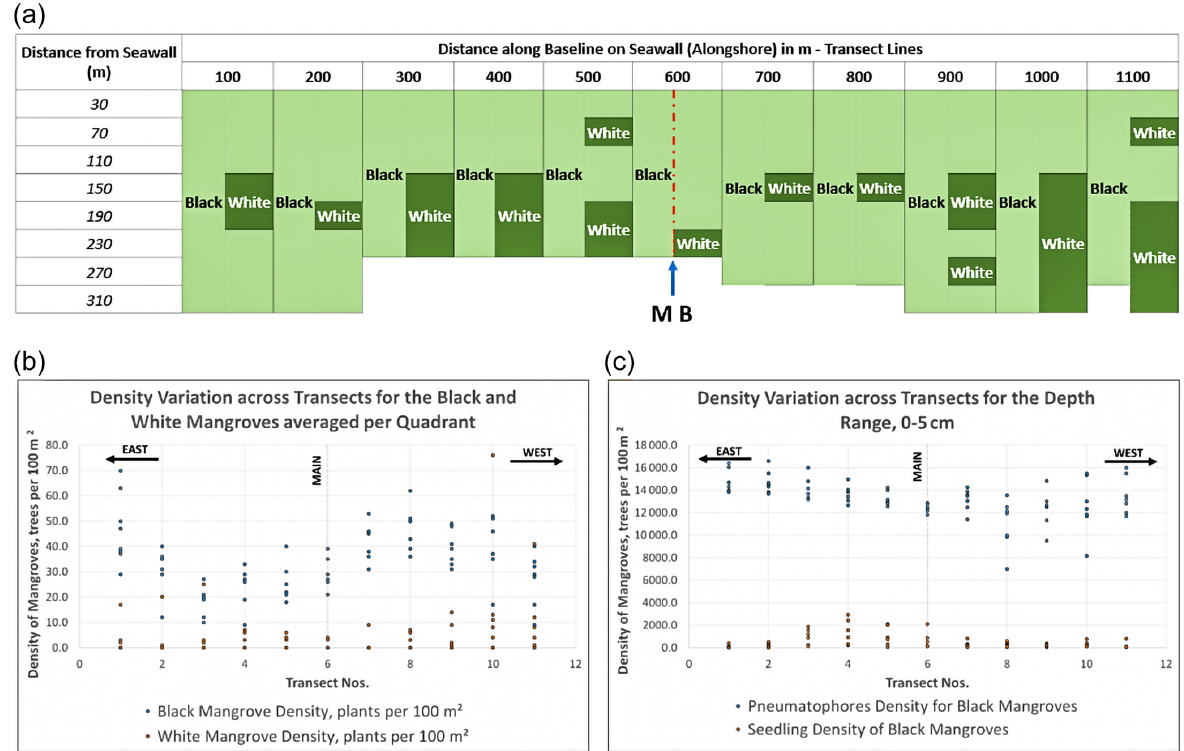
Figure 5. Summary of the spatial variation of the mangrove species and density along the 11 transects at the Chateau Margot mangrove fringe. (a) The demarcation of zones for the two dominant mangrove species, Avicennia germinans (black mangrove) and Laguncularia racemosa (white mangrove). (b) Variation in mangrove density (number of plants per 100m 2 ) for the black and white mangroves. (c) Density variation along depths 0–5cm for the mangrove roots (pneumatophores) and the seedlings for the black mangroves (dominant species). Across the transects there were four red